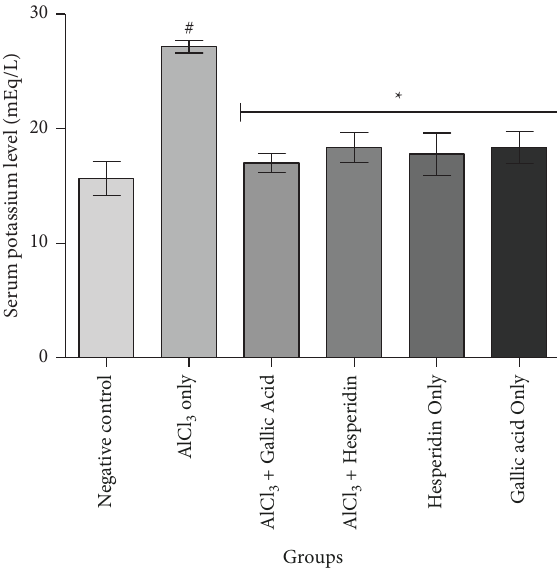
Figure 3: Effect of gallic acid and hesperidin on the serum po- tassium level in AlCl 3 -induced nephrotoxicity in Wistar rats. Values are expressed as the mean ± standard deviation of six de- terminations. # p < 0 . 05 vs negative control, ∗ p < 0 . 05 vs. AlCl 3 only.